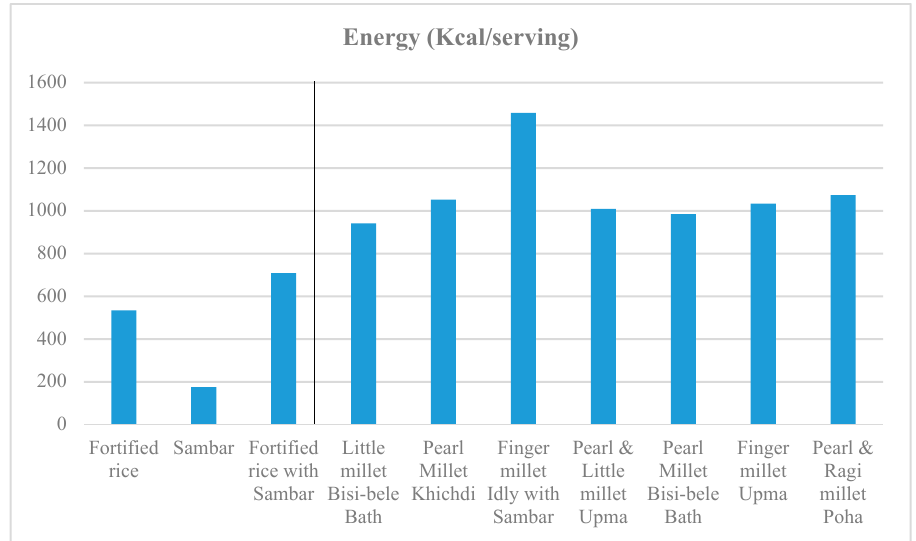
Figure 2. Protein, unsaturated fat and fibre content in millet-based meals in comparison with a fortified rice-based meal.